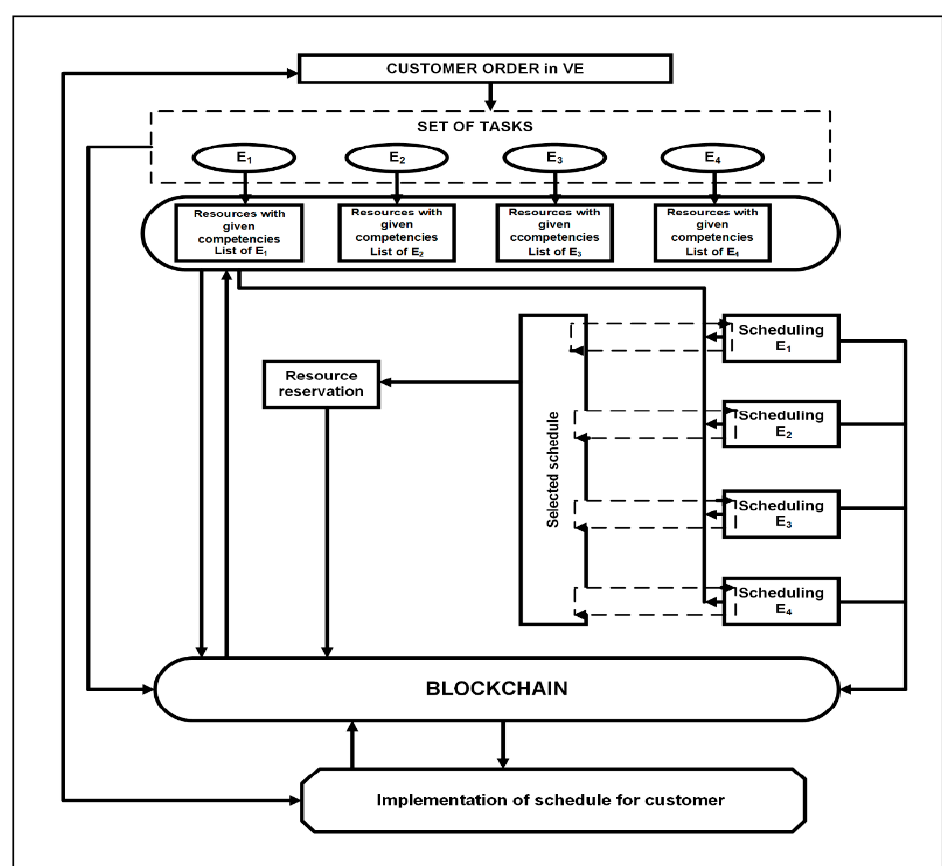
Figure 9. Conceptual model of production and human resources